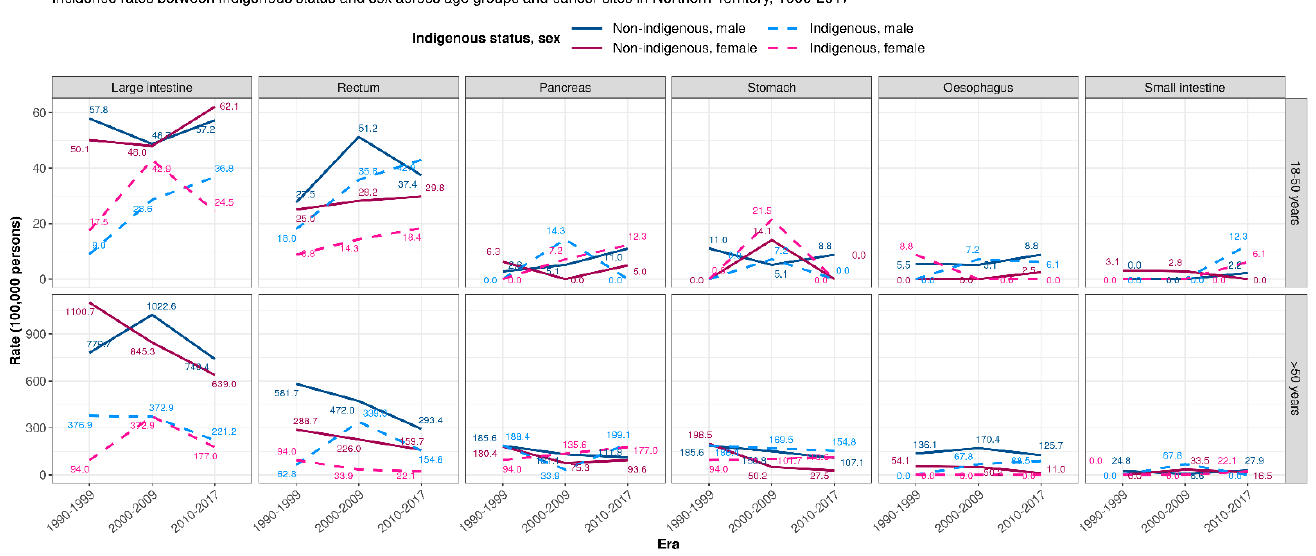
Figure 1. Trend in incidence rates by Indigenous status, sex, and era between two age groups across cancer sites, 1990–2017 ( n = 1608).